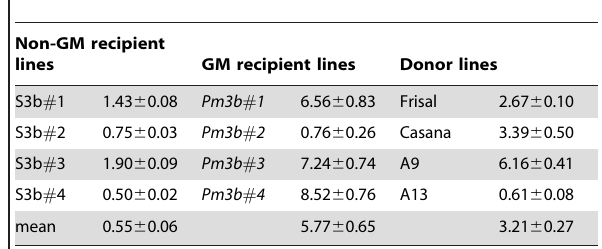
Table 1. Cross-pollination rates (mean 6 1 standard error) of the eight pollen recipient lines (Bobwhite phytometer plants) and the four pollen-donor lines (background